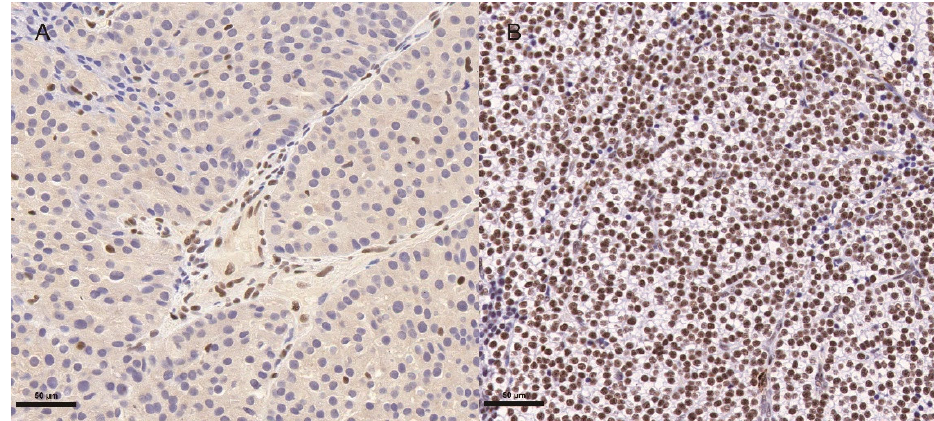
Figure 1. Representative images of parafibromin staining in parathyroid carcinoma tissue. ( A ) Par-